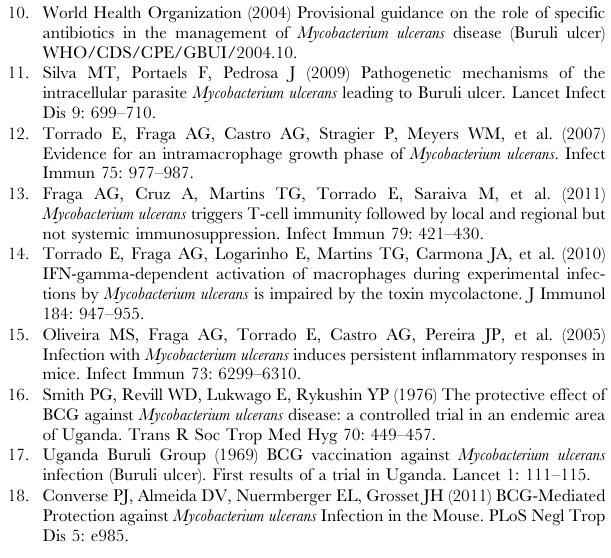
Figure S2 Vaccination with BCG induces an early Th1 N cytokine profile in the DLN of M. ulcerans -infected ) or immunized with mice. Mice were either non-immunized ( BCG ( # ) two months before challenge. All mice were infected in the footpad with 4 log 10 CFU of M. ulcerans 98–912. At different times post-infection, total RNA from the popliteal lymph node was extracted and the presence of mRNA for IL-4 (A) and IL-10 (B) was assessed by real-time PCR. Data points represent the mean 6 SEM ( n = 5–8) for each time point. Statistical significance was calculated with Student’s t test (* p ,